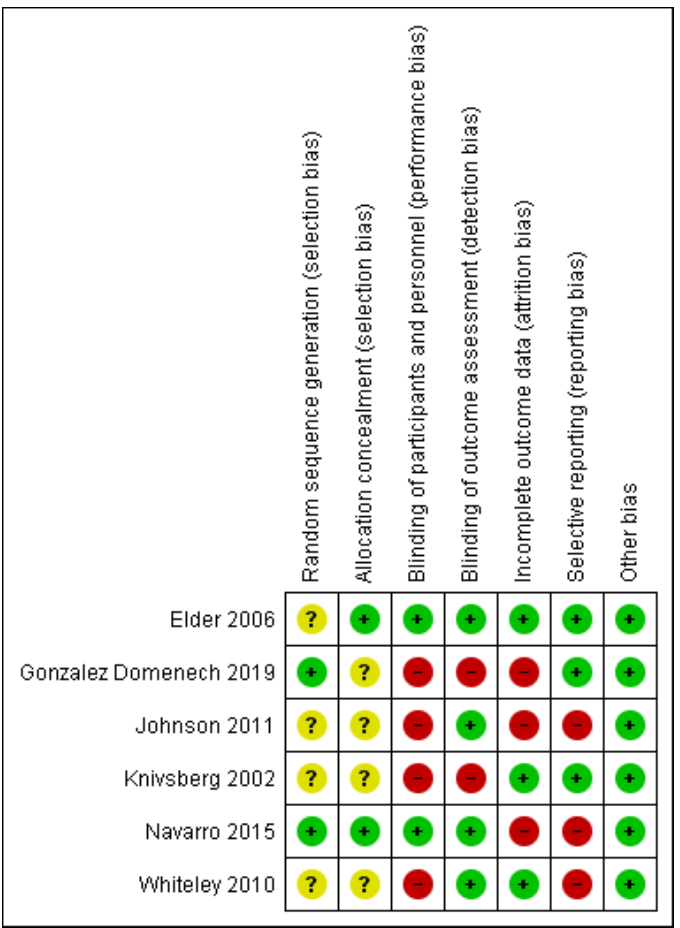
13 of 18 Figure 9. Forest plot of comparison: GFCF vs. usual diet, outcome: body mass index. 3.4. Certainty of Evidence (GRADE) In summary, for both the primary and secondary outcomes, the quality of evidence ranged from low to very low due to serious risk of bias, serious risk of inconsistency, and serious risk of imprecision. A summary of findings can be found in Table 4.